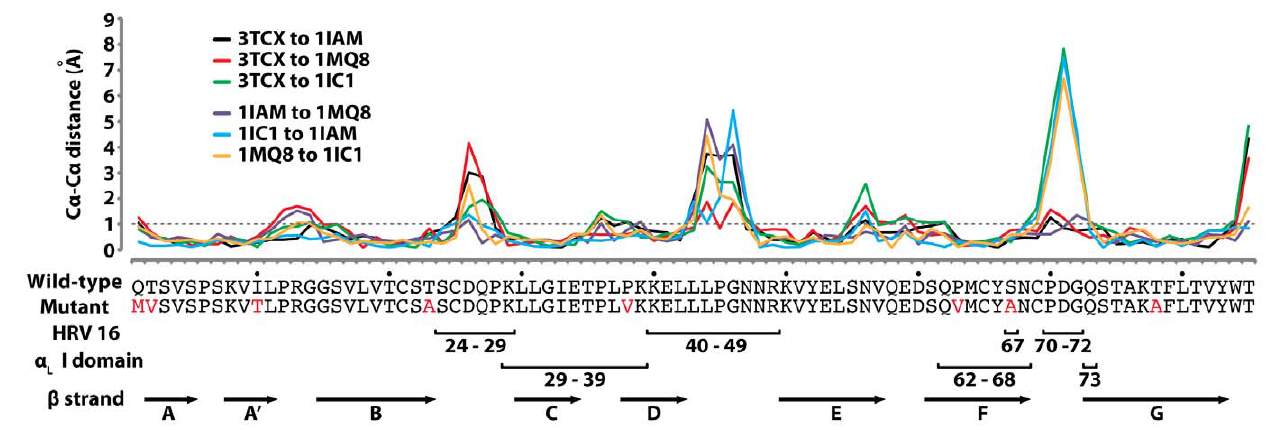
Figure 4. Differences in C a positions for the superimposed structures of ICAM-1 D1. Pair-wise C a -C a distances between wild-type ICAM-1 (1IAM, 1MQ8, and 1IC1) and engineered D1 (3TCX) are plotted. Also, C a - C a distances among the wild-type ICAM-1 structures are plotted (1IAM to 1MQ8, 1IC1 to 1IAM, and 1MQ8 to 1IC1). Putative interacting residues of ICAM-1 D1 with HRV16 capsid as well as the residues in close contact with the a L I domain are indicated with brackets and corresponding residue numbers. Arrow bars denote the residues that form the b -strands in ICAM-1 D1.